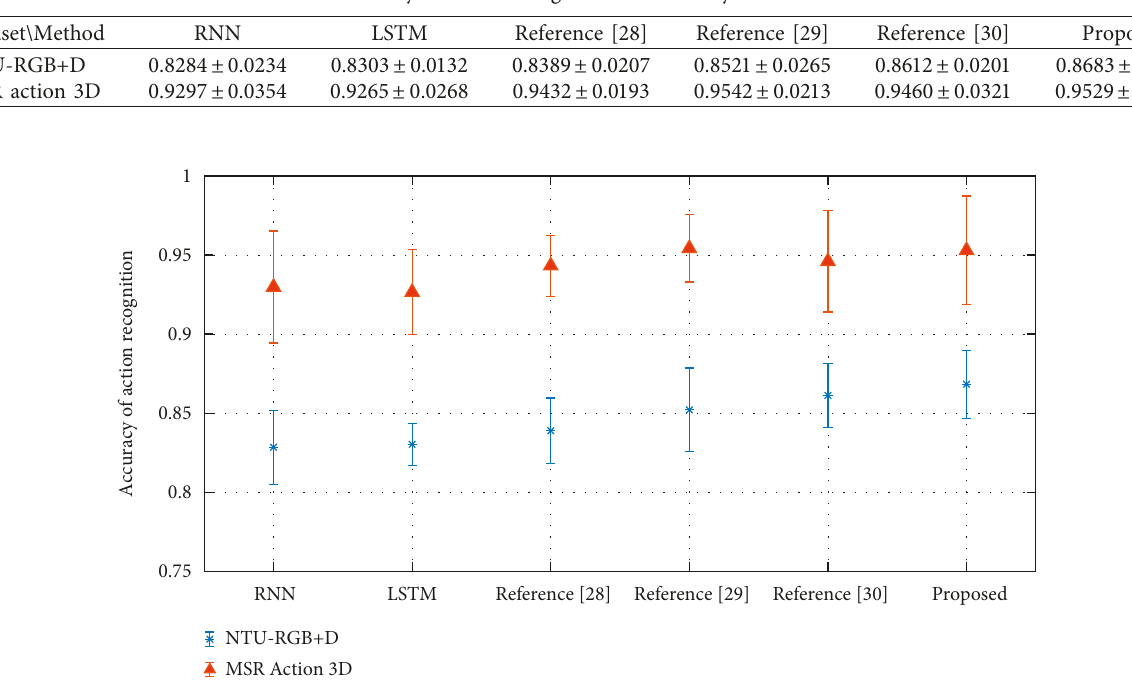
Table 3: Accuracy of action recognition obtained by different methods.